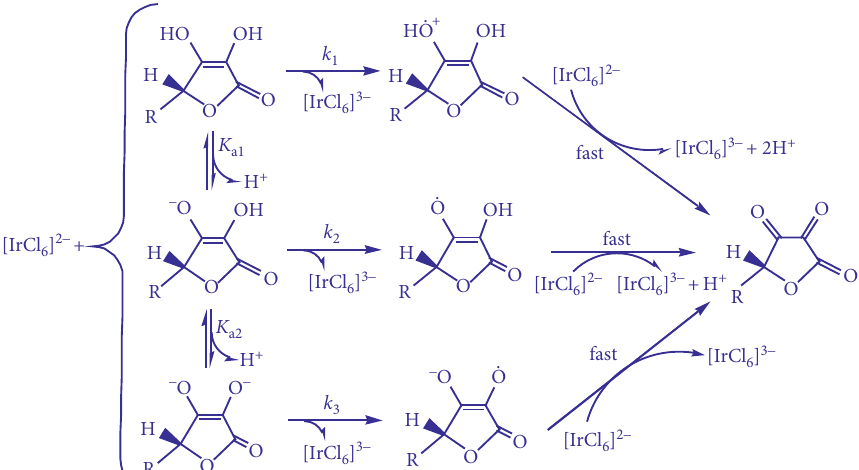
Scheme 2: Schematically deciphering the reaction mechanism for reduction of [IrCl (R represents the side chains of AA and IAA, cf. Scheme